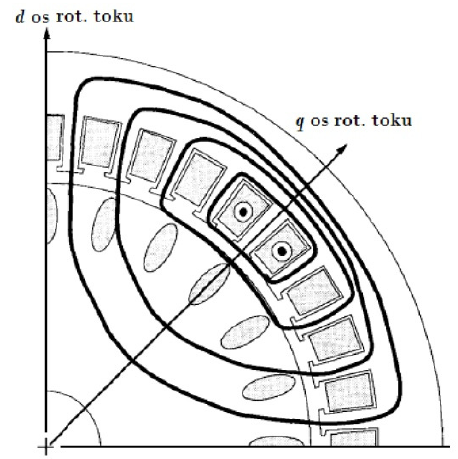
Figure 13. ASM magnetic circuit saturation .